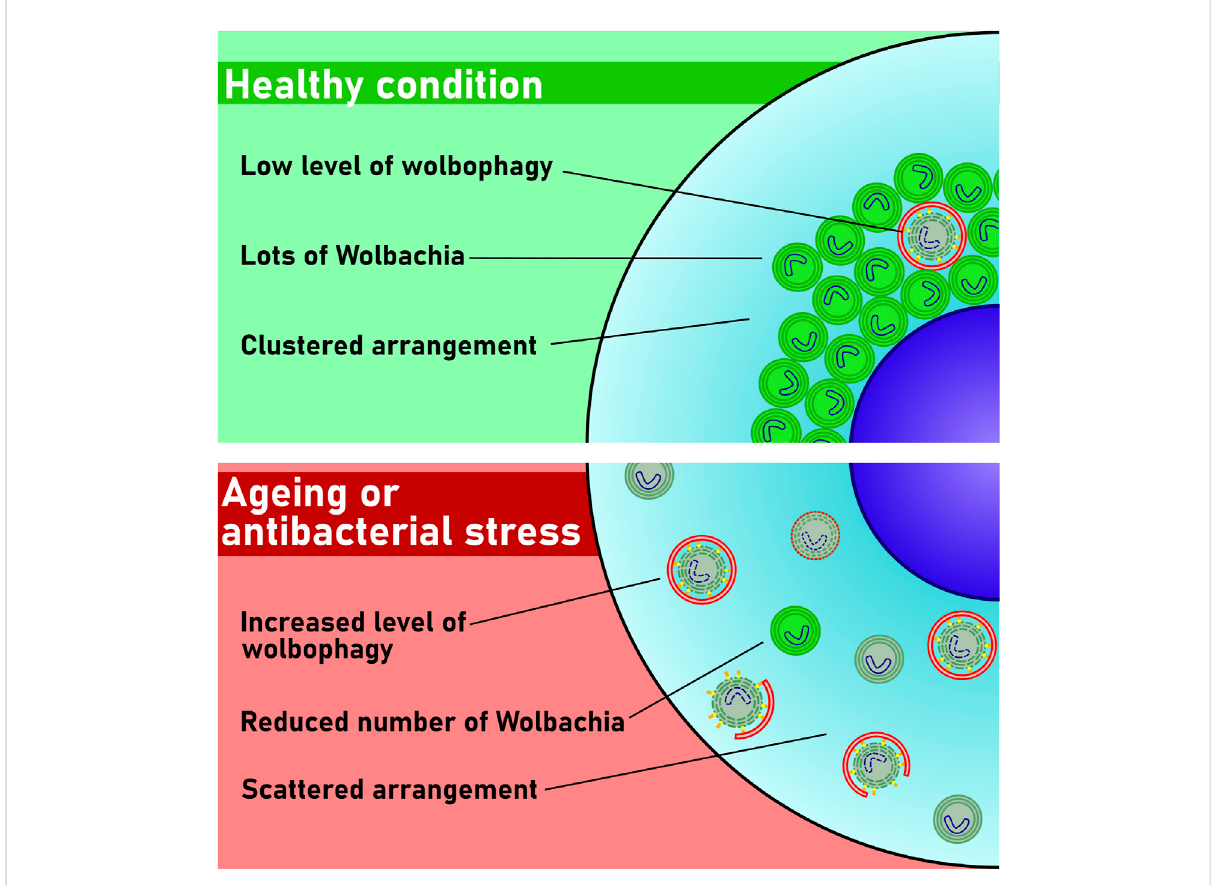
FIGURE 4 Model of wolbophagy. Only a few bacteria are damaged and thus eliminated in healthy cells. The number of damaged Wolbachia increases during aging or upon antibiotic stress. These damaged bacteria are then targeted by autophagy, and perhaps also by conjugation of Atg8 to single membranes (CASM) for elimination by